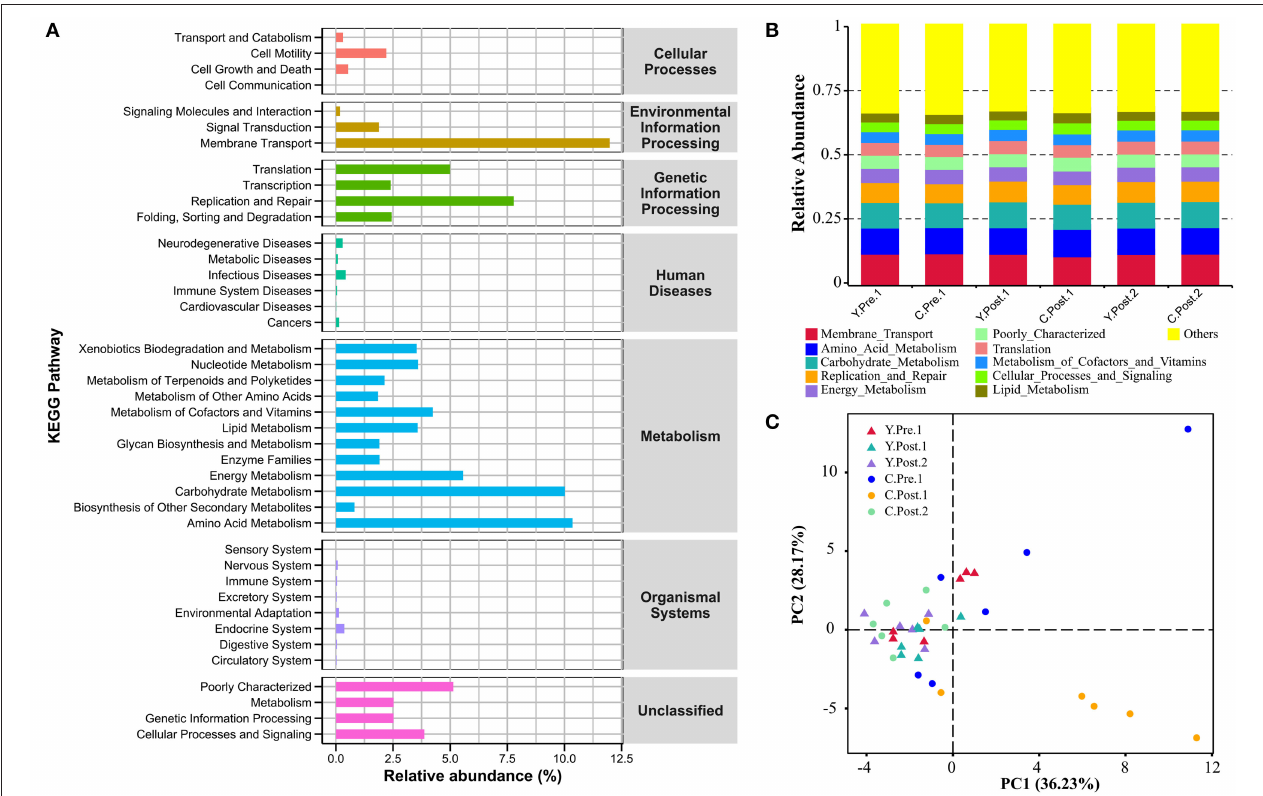
FIGURE 5 | Prediction of the potential function of microbial community in bovine udder skin using PICRUST. (A) The bar graph shows the main potential function of the udder skin microbial community of yak and cattle in the perinatal period on KEGG Level 1 and Level 2. (B) The stacked bar chart shows the major microbial functions of the microbial community in the udder skin of yak and cattle at KEGG Level 2 at different time points during the perinatal period. (C) Principal component analysis (PCA) shows microbial functional diversity across all samples.